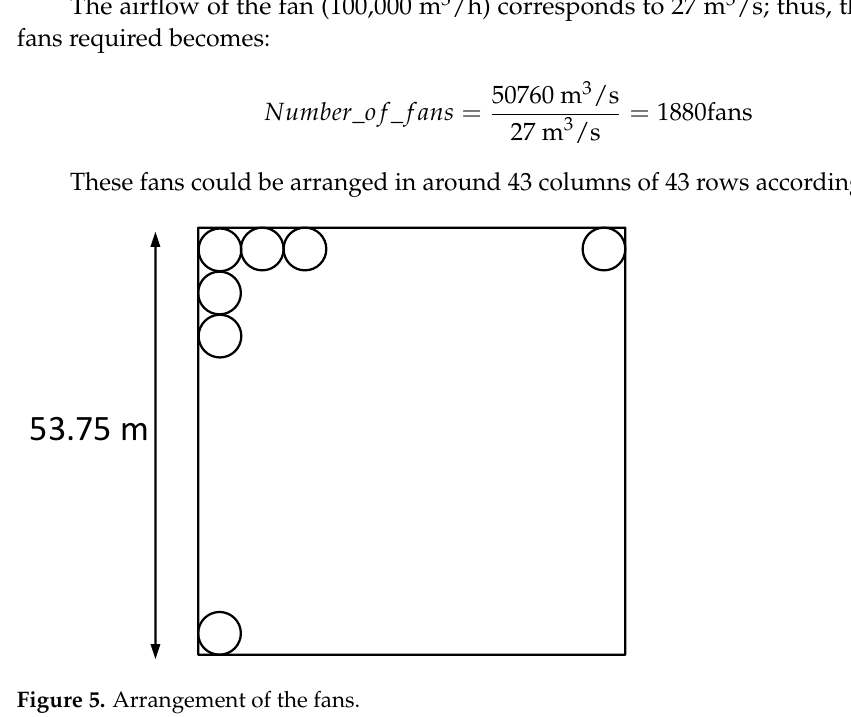
Figure 5. Arrangement of the fans .